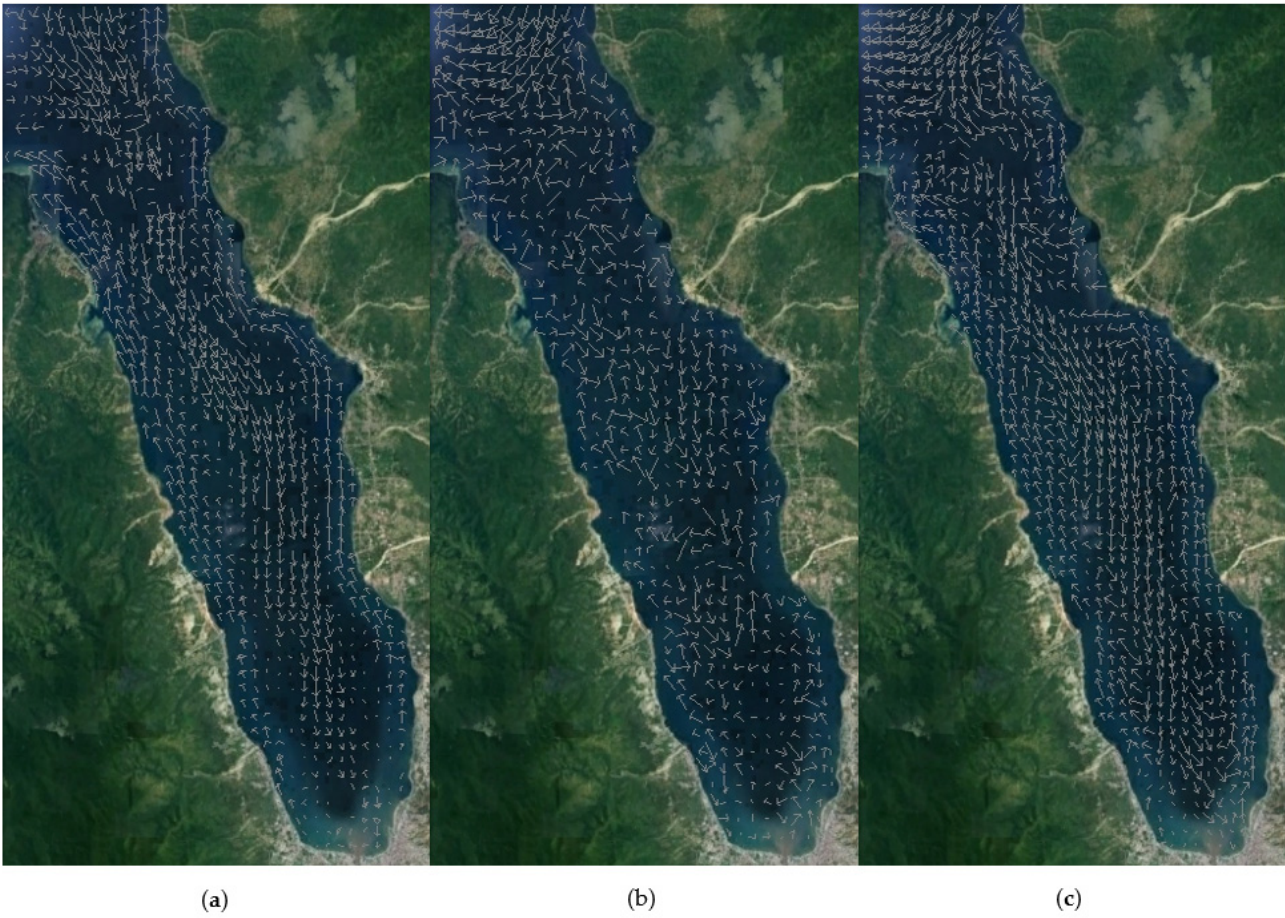
Figure 4. The average of ssa surface current pattern for model I ( a ) generated by wind; ( b ) generated by tide; and ( c ) generated by wind and tide.